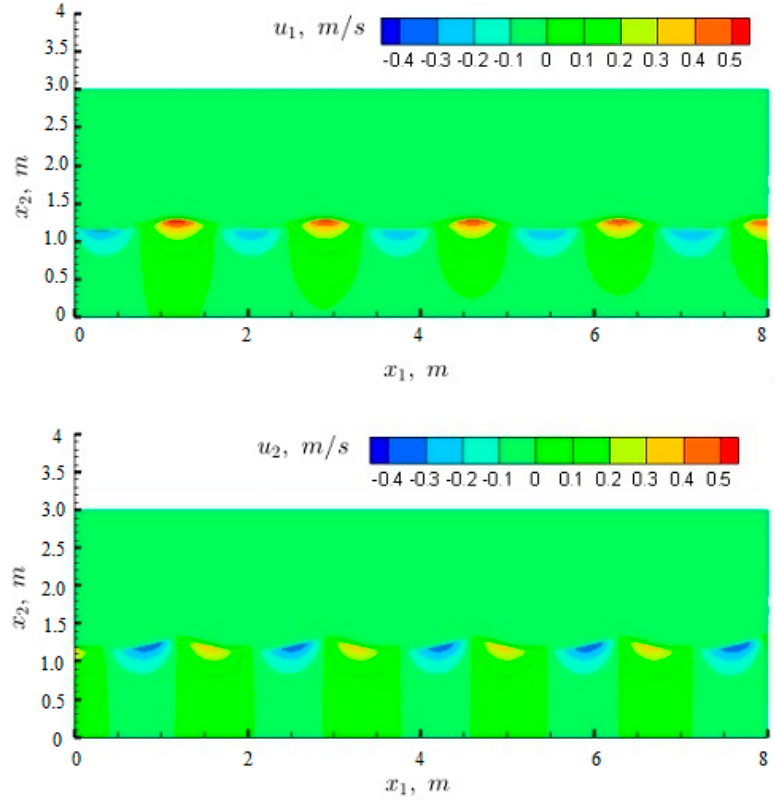
Figure 3. Instantaneous contours of vertical ( top ) and horizontal ( bottom ) velocities after the flow is fully developed. Horizontal velocity is positive to the right and vertical velocity is positive upward.